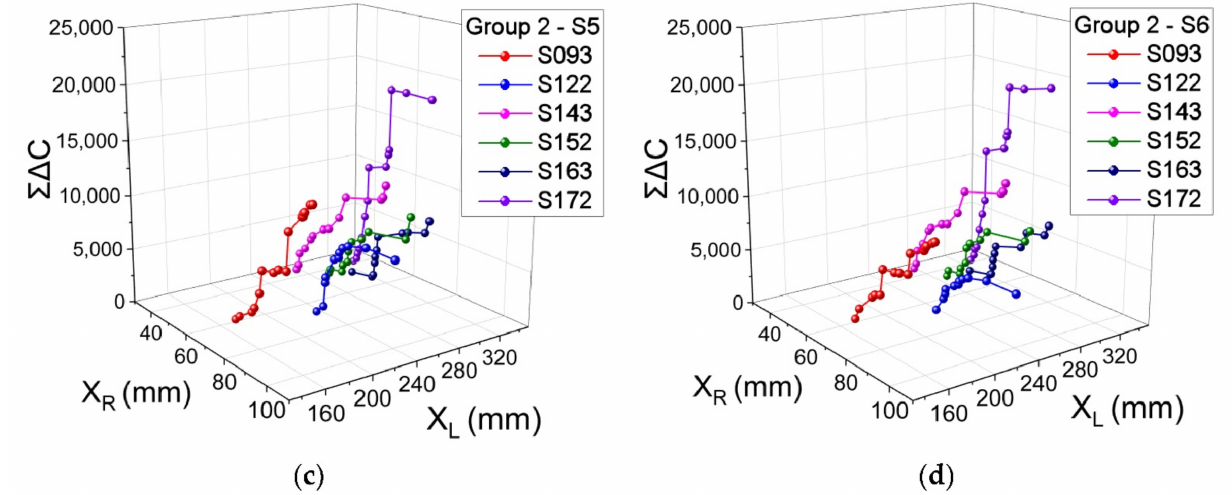
Figure 9. Three-dimensional graph: x-axis—radial position X R (mm); y-axis—longitudinal position X L (mm); z-axis— cumulative sum of the counts, i.e., Σ∆ C. ( a ) Group 1, S5; ( b ) Group 1, S6; ( c ) Group 2, S5; and ( d ) Group 2, S6.